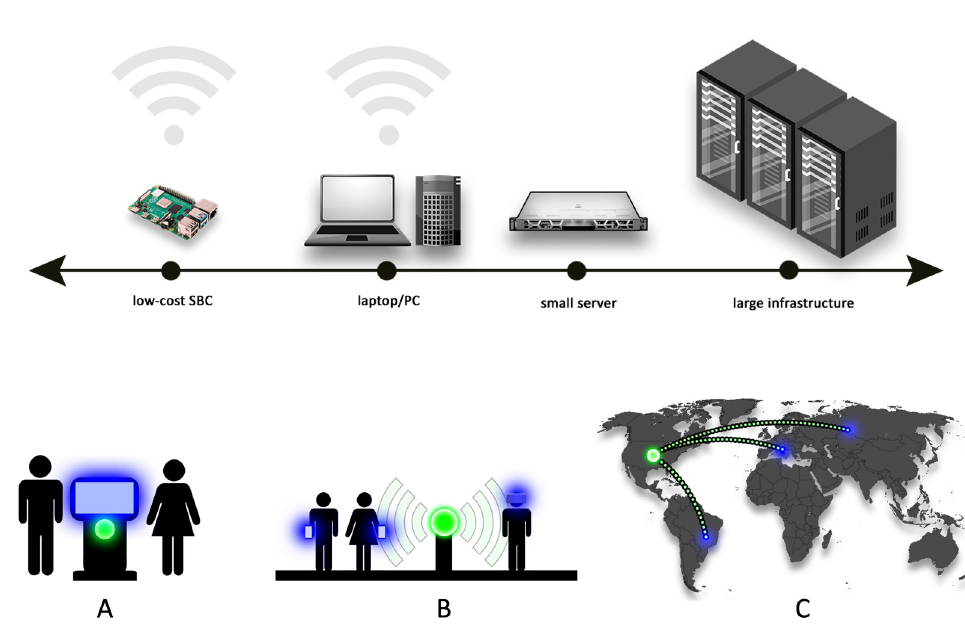
Figure 3. Deployment hardware ( top ) and ( A – C ) three different deployment scenarios ( bottom